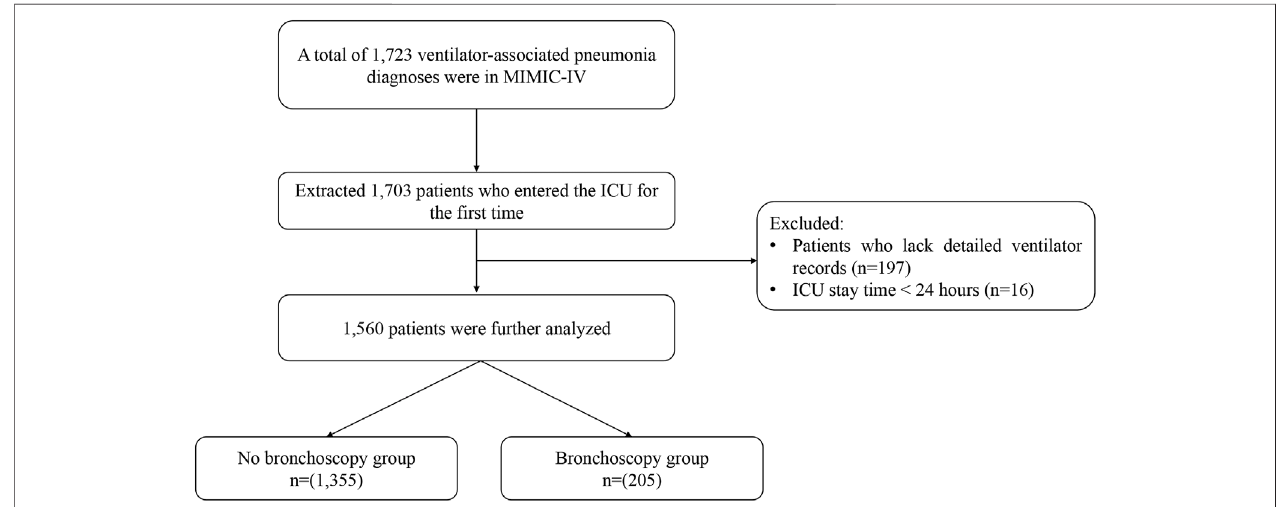
FIGURE 1 | Inclusion and exclusion fl owchart of the